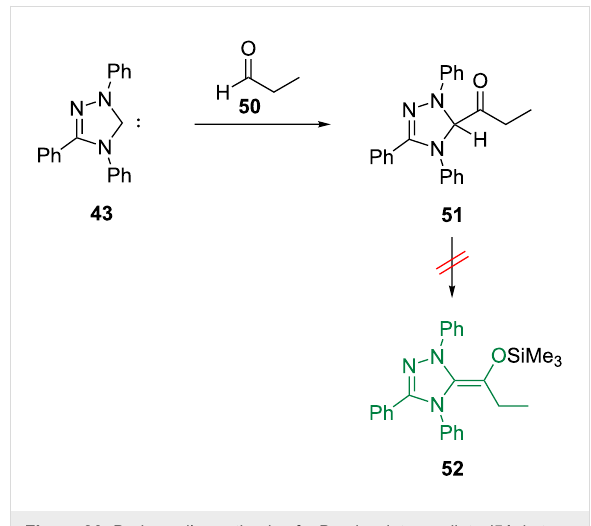
Figure 26: Berkessel’s synthesis of a Breslow intermediate ( 51 , keto tautomer) from carbene 43 [112].